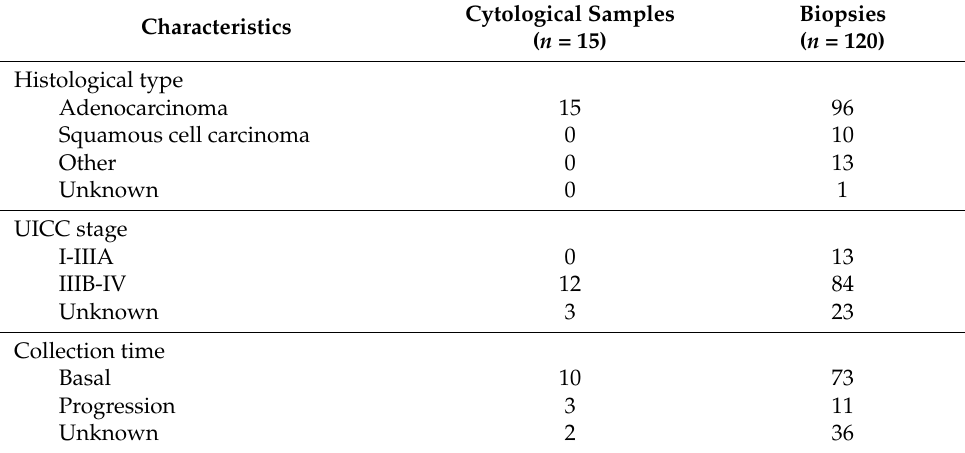
Table 2. Characteristics of the valid samples included in the